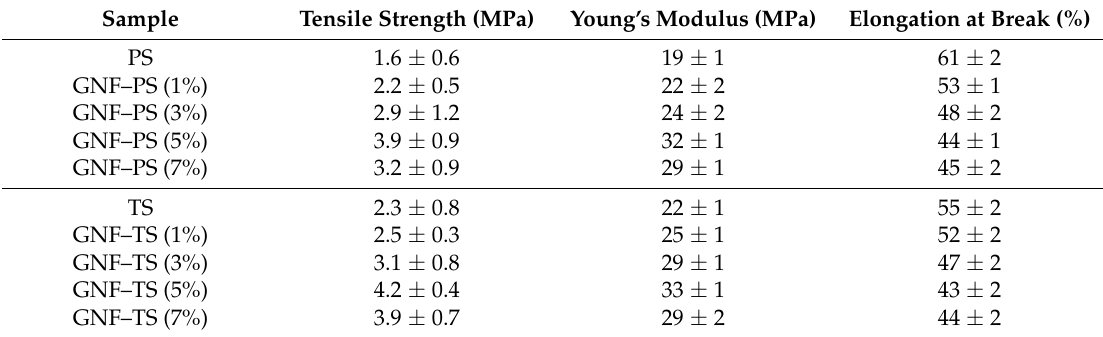
Table 1. Mechanical properties of the GNF–PS and GNF–TS composites with different